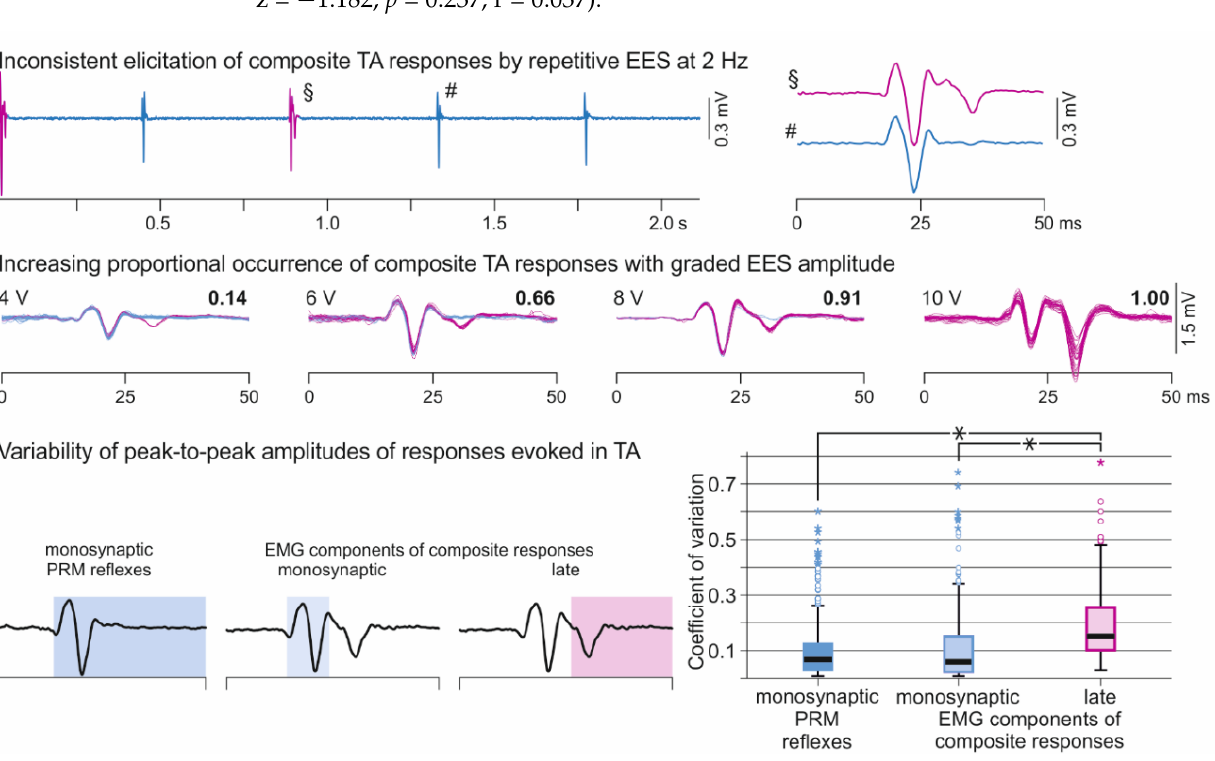
Figure 6. Inconsistent elicitation and variability of late EMG components in TA. ( a ) EMG recording of TA shows the elicitation of monosynaptic PRM reflexes as well as composite responses with constant stimulation parameters; subject 1, recording 1, electrode setup 0+3 − , 4 V. Responses marked by § and # are illustrated in enlarged time scale on the right. ( b ) Monosynaptic (blue) and composite (magenta) responses of TA evoked with increasing EES amplitudes as indicated. Bold numbers depict proportional occurrences of composite responses. Twenty-three to 36 stimulus-triggered EMG traces shown superimposed in each panel; subject 3, recording 1, 1+3 − . ( c ) Variability of EMG peak-to-peak amplitudes of monosynaptic PRM reflexes (analysis time window: response onset to 50 ms post-stimulus; n = 730) as well as of monosynaptic (response onset to offset of monosynaptic component) and late EMG components (offset of monosynaptic component +2 ms to 50 ms post-stimulus) of composite responses for cases with a proportional occurrence of 1 ( n = 269). Boxplots show the distributions of the coefficient of variation of the peak-to-peak amplitudes of responses as indicated. Circles illustrate outliers and asterisks extreme values. EES, epidural electrical stimulation; PRM, posterior root-muscle; TA, tibialis anterior; *, p < 0.05.